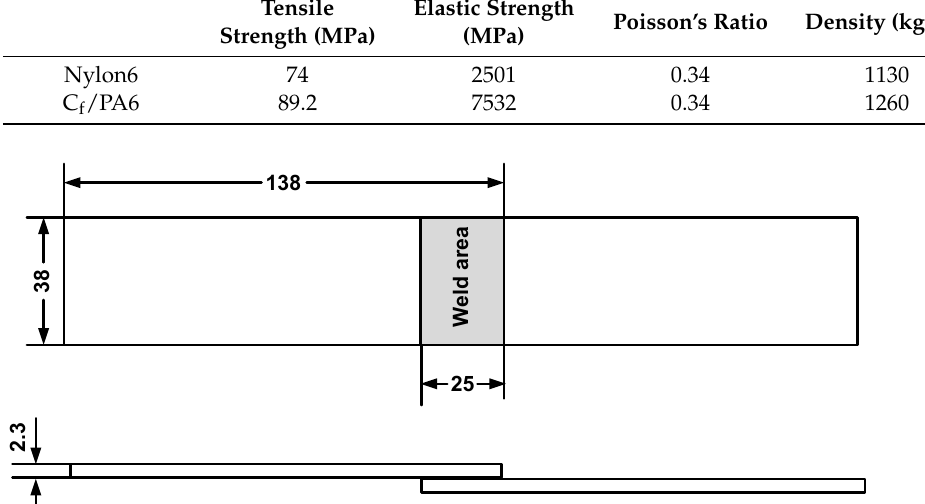
Figure 1. Schematic of the single-lap weld specimen (Dimensions in mm).